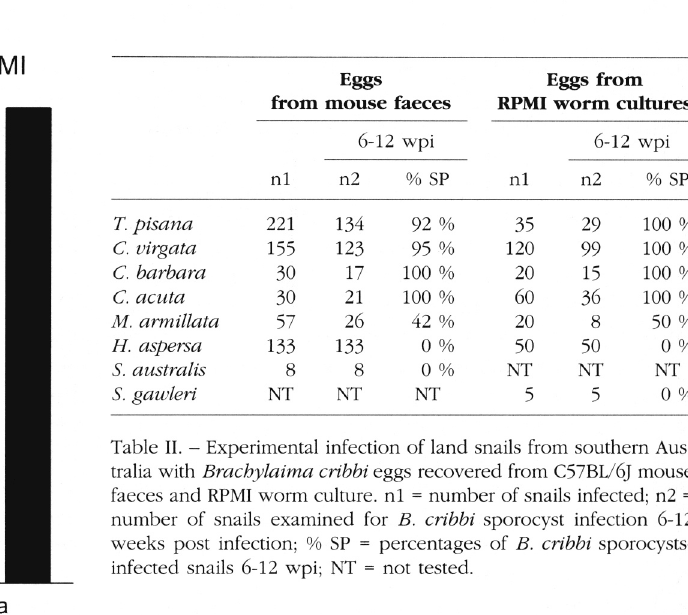
Table II. - Experimental infection of land snails from southern Aus­ tralia with Brachylaima cribbi eggs recovered from C57BL/6J mouse faeces and RPMI worm culture, nl = number of snails infected; n2 = number of snails examined for B. cribbi sporocyst infection 6-12